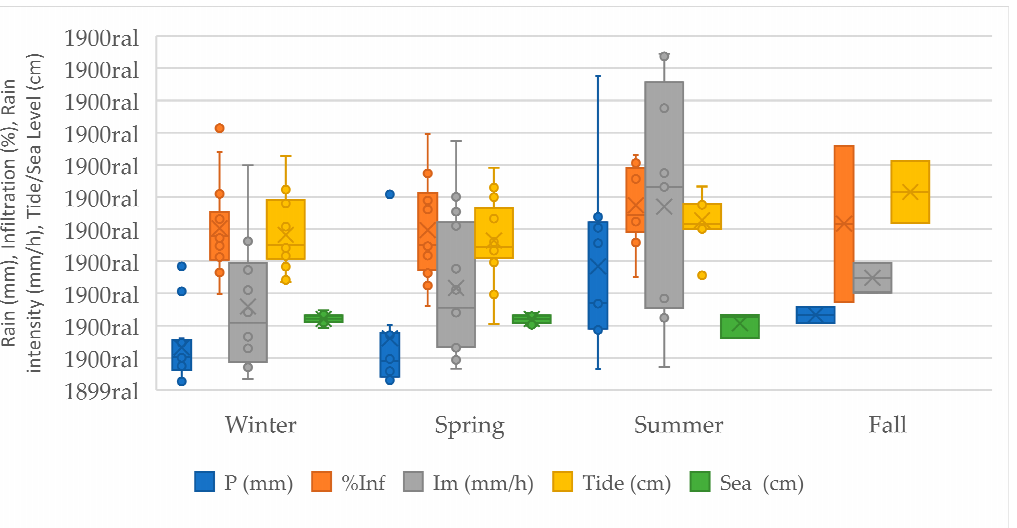
Figure 3. Variation in rain height (P), medium intensity (Im), daily sea level (cm), daily tide level (cm), and percentage volume infiltrated (%Inf) in the swale.